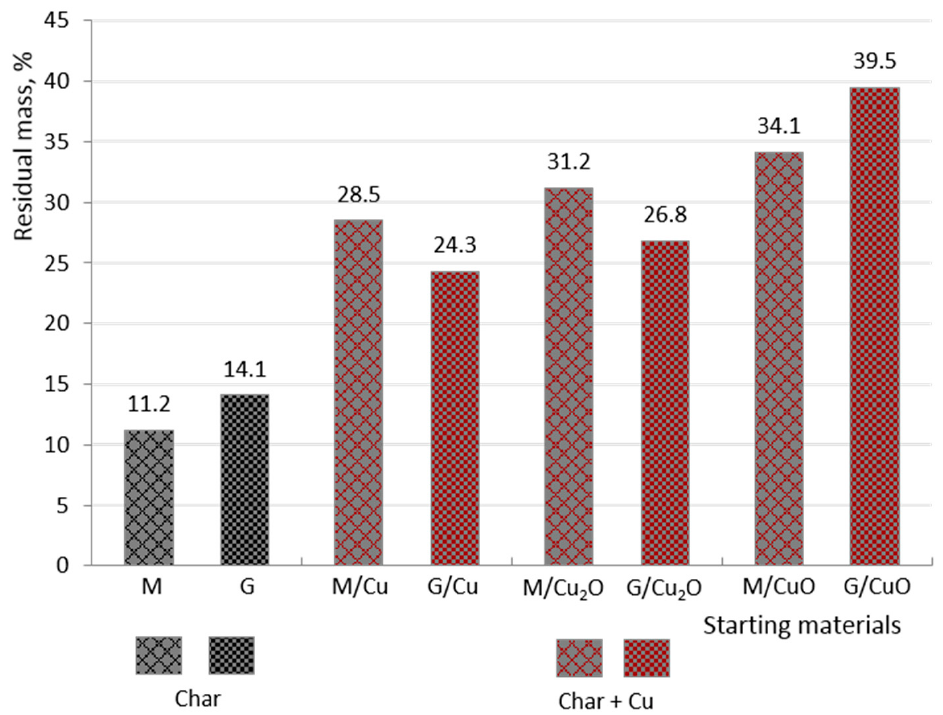
Scheme 2. Solid residues in N 2 of examined materials (M/Cu 2 O, M/Cu, G/Cu 2 O, G/Cu) in comparison to pure anion exchangers (M, G) and CuO doped anion exchangers (M/CuO, G/CuO) [31].